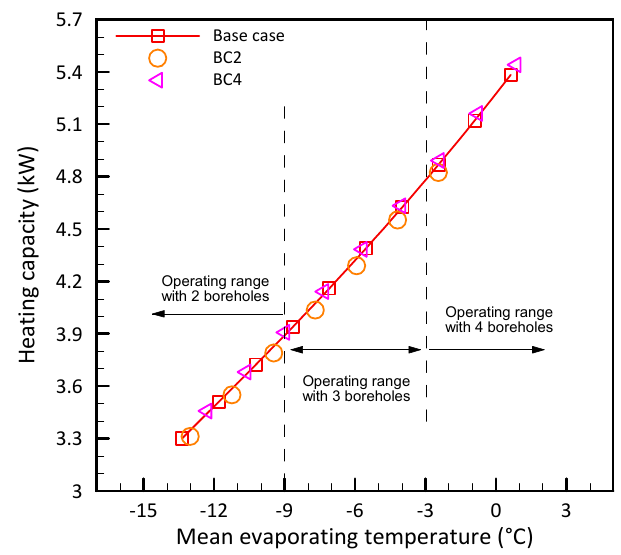
Figure 12. Coefficient of performance ( COP heating ).